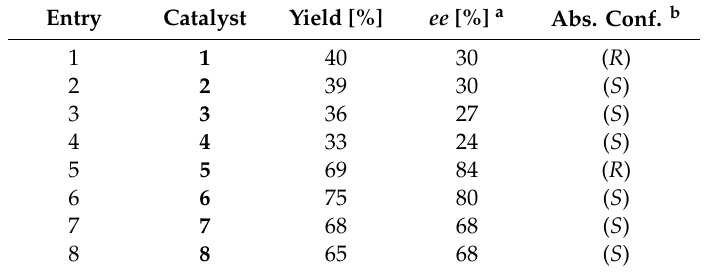
Table 1. Asymmetric Friedel–Crafts alkylation of indole catalyzed by aziridine-phosphines 1–8 . Entry Catalyst Yield [%] ee [%] a Abs. Conf. b